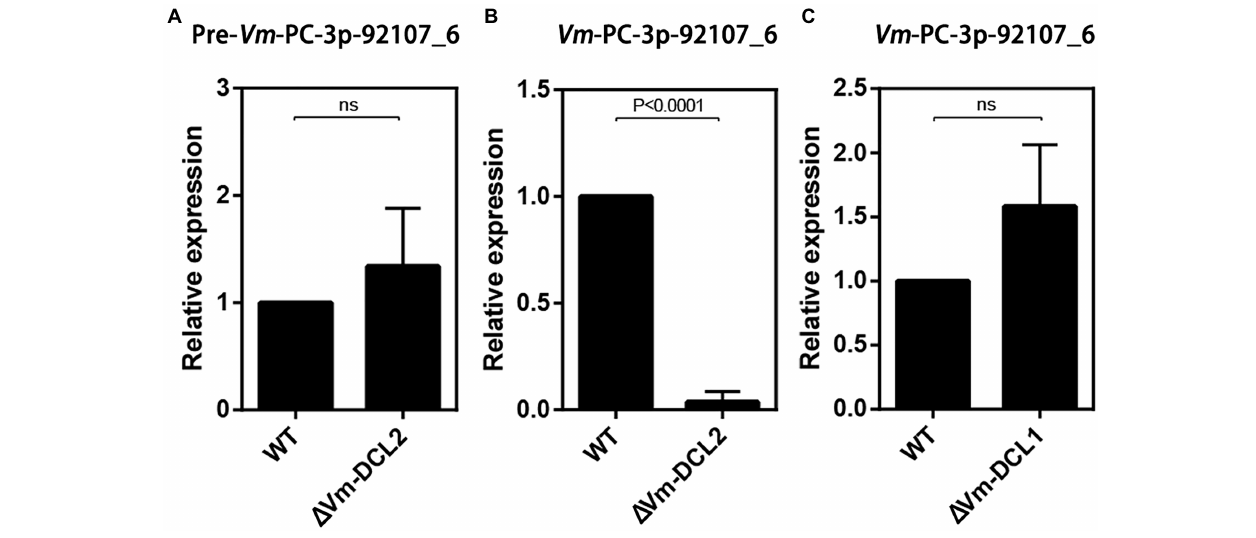
FIGURE 2 | Relative expressions of pre- Vm -PC-3p-92107_6 and Vm -PC-3p-92107_6 by quantitative real-time PCR. (A) Relative expression of pre- Vm -PC- 3p-92107_6 in Vm - DCL2 deleted mutant ( Δ Vm - DCL2 ). Vm - G6PDH was selected to reference gene and the relative expression level of pre- Vm -PC- 3p-92107_6 in WT was set to 1 by the 2 −ΔΔ Ct method. (B) Relative expression of Vm -PC-3p-92107_6 in Vm - DCL2 deleted mutant ( Δ Vm - DCL2 ). Vm -U6 was selected to reference gene and the relative expression level of Vm -PC-3p-92107_6 in WT was set to 1. (C) Relative expression of Vm -PC-3p-92107_6 in Vm - DCL1 deleted mutant ( Δ Vm - DCL1 ). Vm -U6 was selected to reference gene and the relative expression level of Vm -PC- 3p-92107_6 in WT was set to